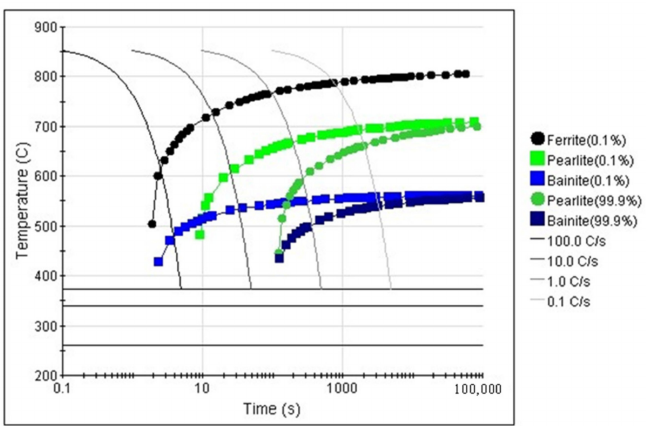
Figure 2. Continuous cooling transformation (CCT) diagram of HRB500.